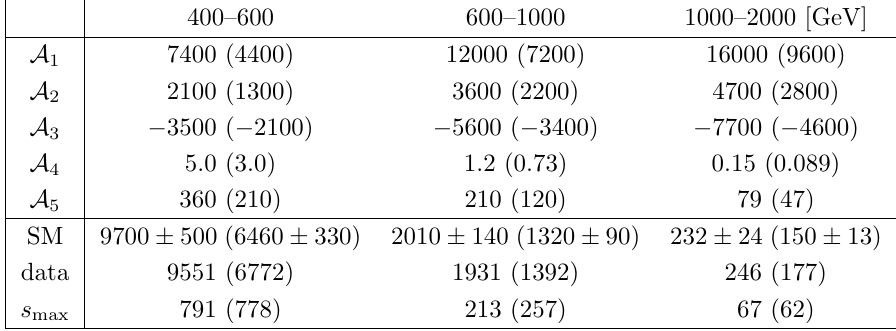
Table 2 . Coe(cid:14)cients in TeV 4 and rounded to two signi(cid:12)cant (cid:12)gures for pp ! ‘N obtained upon recasting the experimental analysis of ref. [24] for L = 36 fb (cid:0) 1 . The numbers outside (inside) the parentheses refer to the ‘ = e ( (cid:22) )